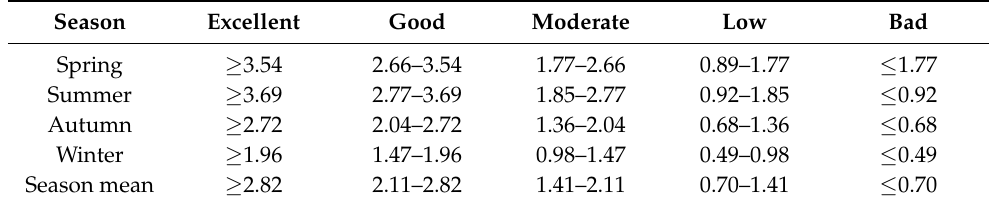
Table 2. Assessment criteria for the P–IBI in the Yitong River